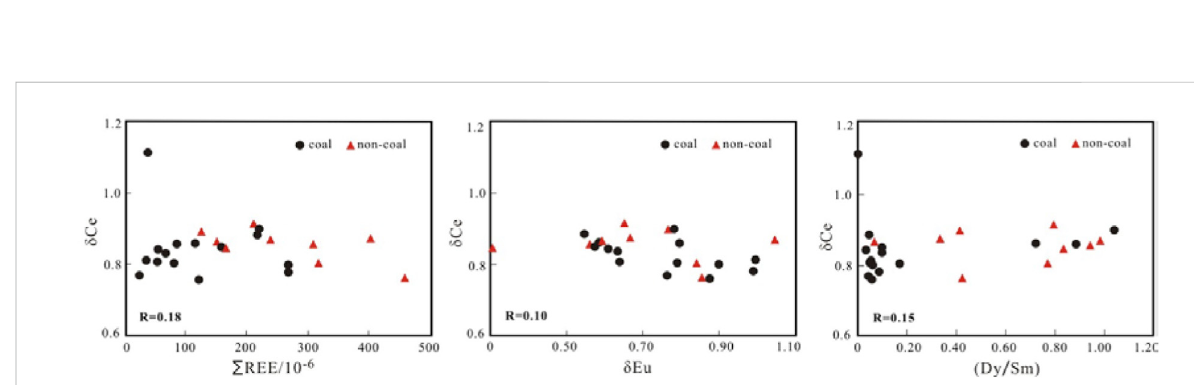
(cid:1) REE in the C N and 1 coal of Yantang Mine, Xuanwei,